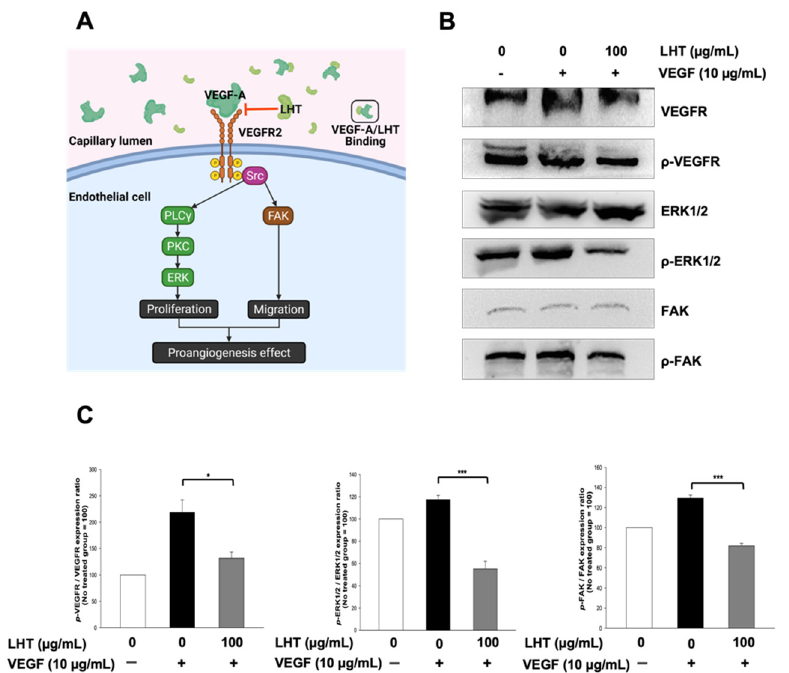
Figure 6. Inhibition effect of LHT on the cellular proliferation and migration through VEGF recep- tor, ERK and FAK pathways. ( A ) Multiple signaling pathways from the VEGF-A/VEGFR2 interaction to induce cellular migration and proliferation. LHT inhibits VEGF-A/VEGFR2 binding through VEGF-A/LHT interactions. ( B ) Western blot (cropped blots) of cell lysate of HUVECs after cultivation with VEGF (10 ng/mL) or VEGF with LHT (100 µg/mL) for 24 h. Full-length blots were presented in Supplementary Figure S4. ( C ) Quantitative analysis of Western blotting bands cell lysate of HUVECs after cultivation with VEGF (10 ng/mL) or VEGF with LHT (100 µg/mL) for 24 h . Data were expressed with mean ± s.e.m. (n = 3). * p < 0.05, *** p < 0.001 versus the VEGF-treated group.